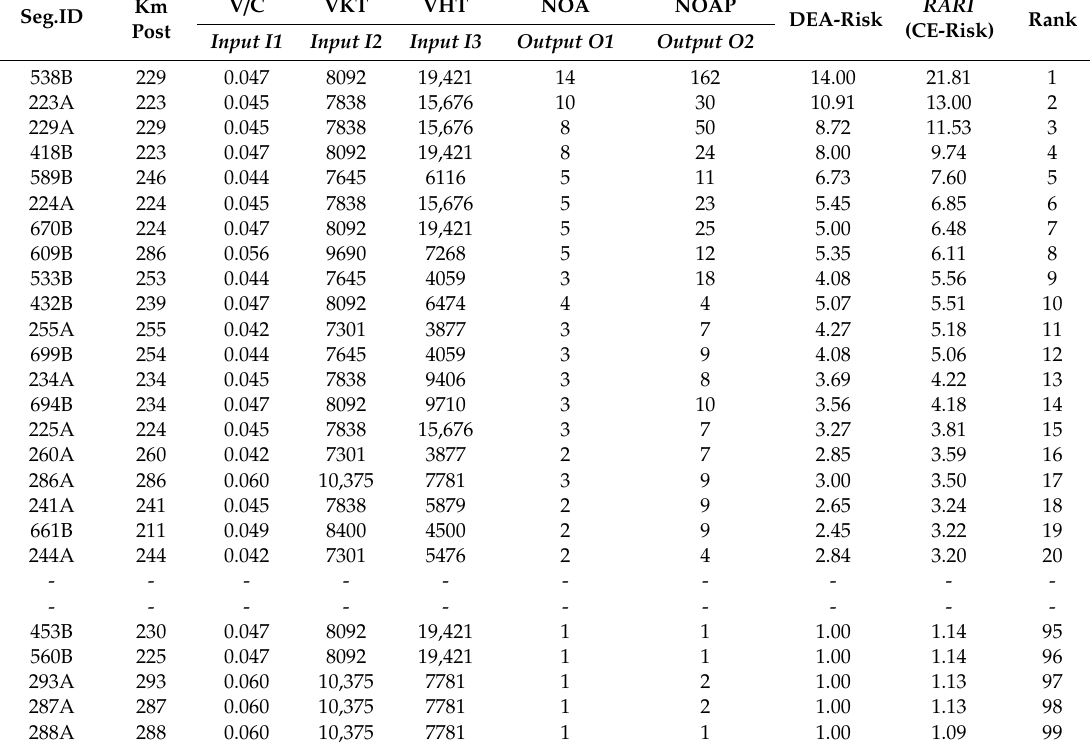
Table 3. Road accident risk index (RARI) calculation mechanism using DEA.